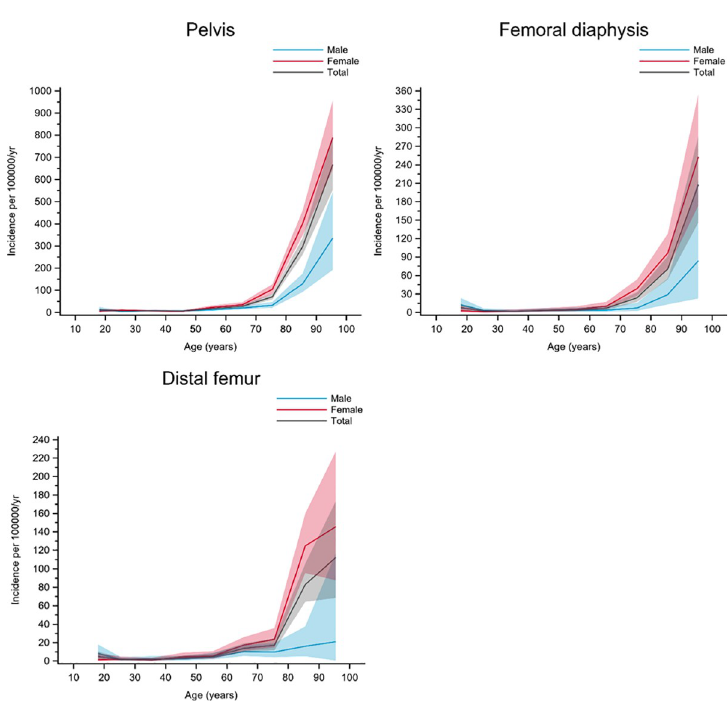
Fig 3. Fractures in group B. Age- and gender-specific incidence with 95% confidence interval. Black line represents the total population; red line represents females and blue line represents males.